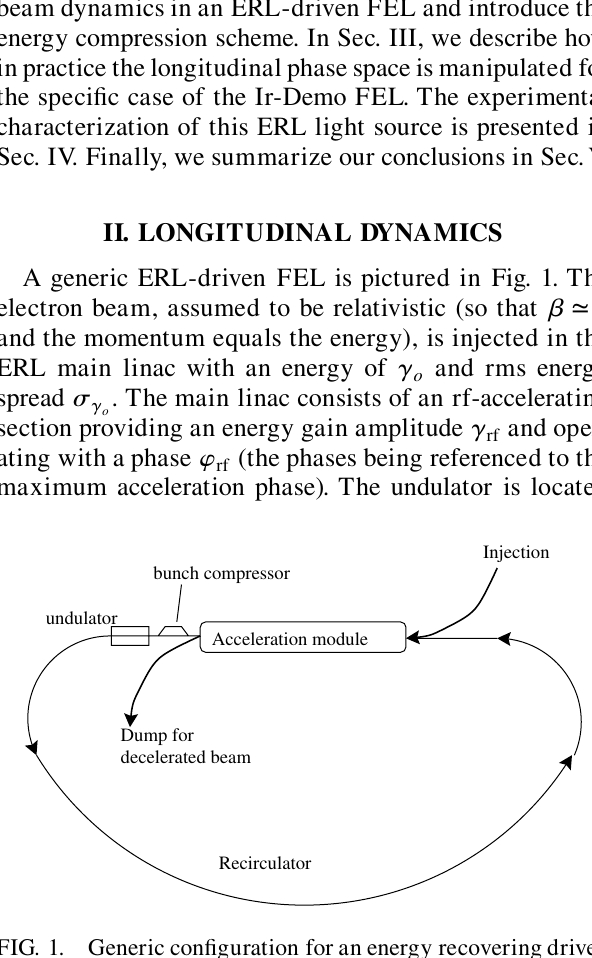
FIG. 1. Generic configuration for an energy recovering driven